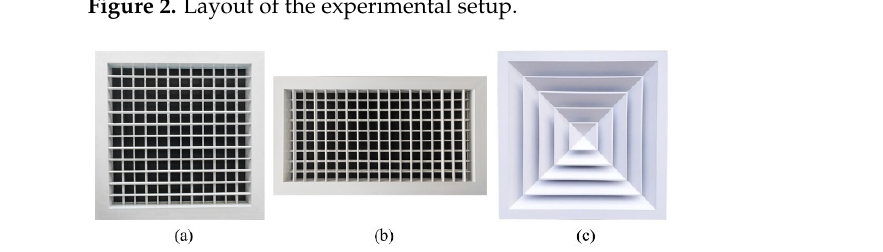
Figure 3. Types of supply air diffusers. ( a ) SGD; ( b ) RGD; ( c )